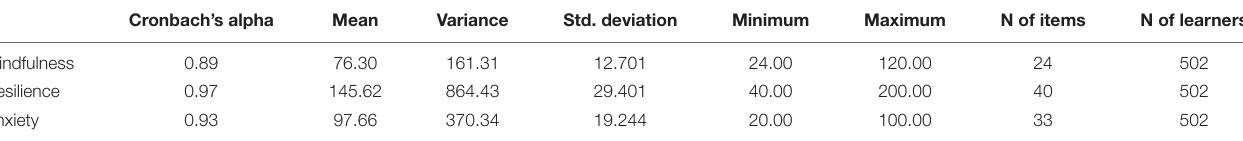
TABLE 1 | Reliability and descriptive statistics.